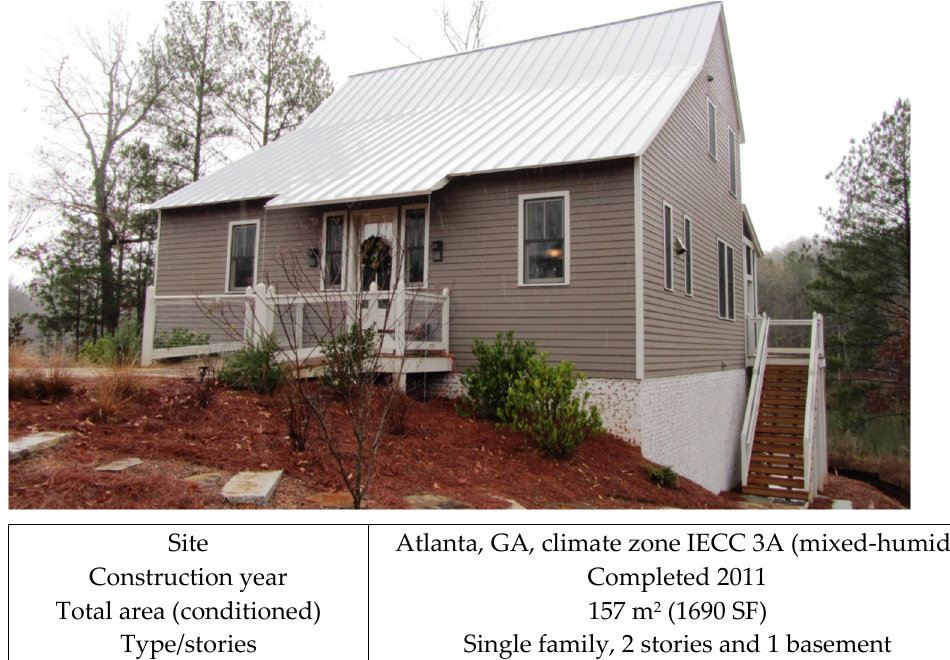
Figure 4. Planning characteristics of building A. Source: Butler et al. [36]. Table 4. Building A (Nest Cottage) Specifications. Data from Butler et al.